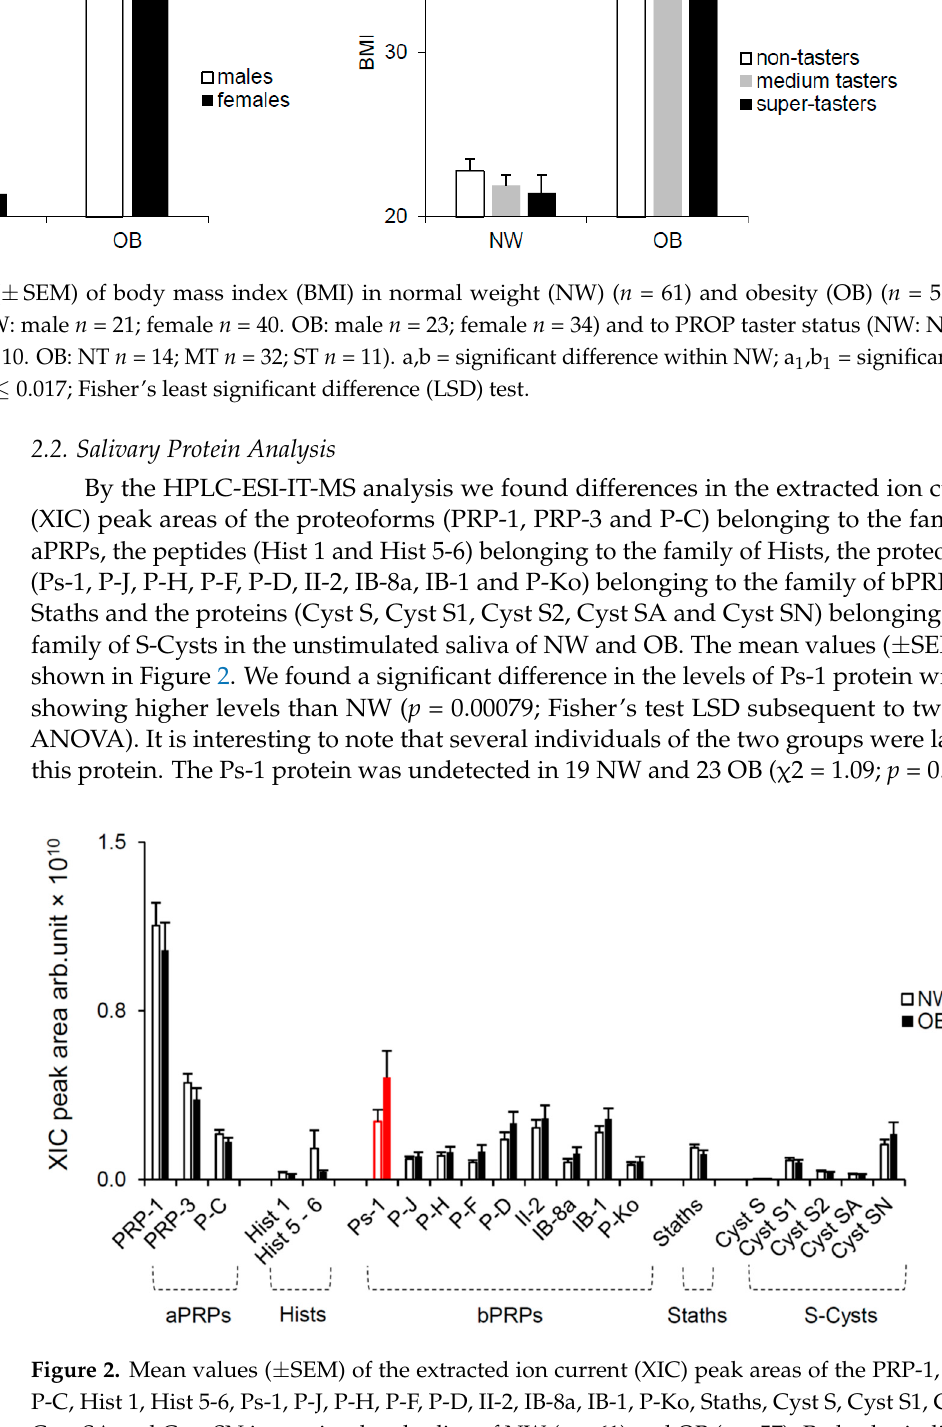
Figure 2. Mean values (±SEM) of the extracted ion current (XIC) peak areas of the PRP ‐ 1, PRP ‐ 3, P ‐ C, Hist 1, Hist 5 ‐ 6, Ps ‐ 1, P ‐ J, P ‐ H, P ‐ F, P ‐ D, II ‐ 2, IB ‐ 8a, IB ‐ 1, P ‐ Ko, Staths, Cyst S, Cyst S1, Cyst S2, Cyst SA and Cyst SN in unstimulated saliva of NW ( n = 61) and OB ( n = 57). Red color indicates a significant difference between NW and OB ( p = 0.00079; Fisher’s test LSD). 2.2.1. Effect of Gender Figure 3 shows the mean values (±SEM) of the XIC peak areas of the same proteins belonging to the families of aPRPs, Hists, bPRPs, Staths and S ‐ Cysts measured in unstim ‐ ulated saliva of NW and OB males (lower graph) and females (upper graph). Three ‐ way